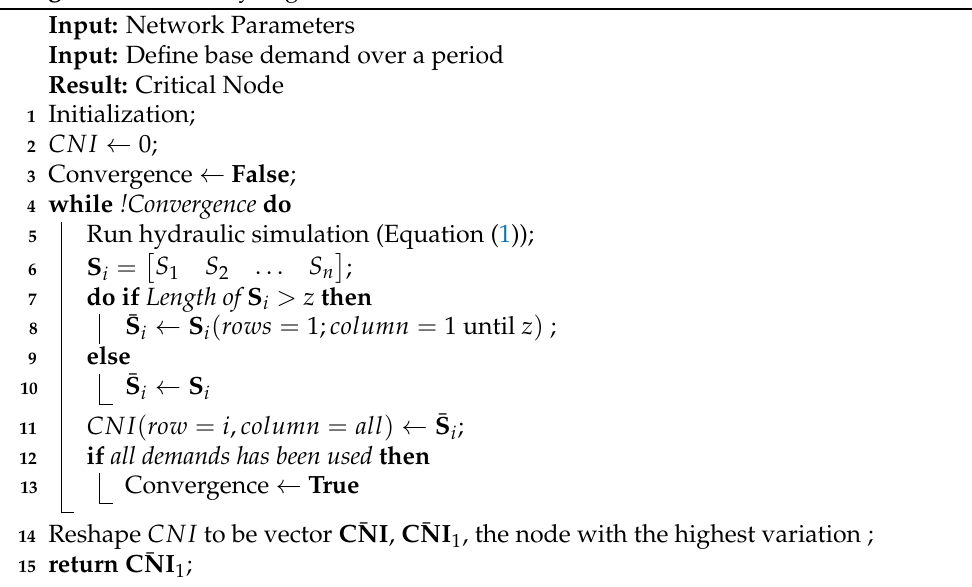
Algorithm 1: Greedy Algorithm for Identification of Critical